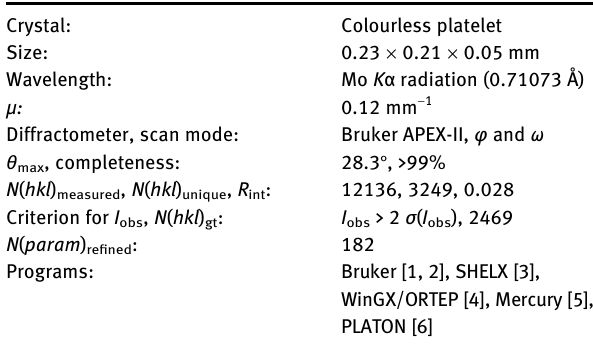
Table  : Data collection and